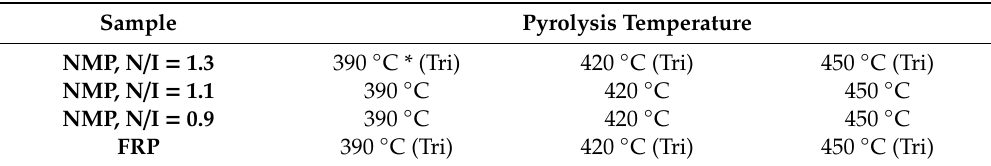
Table 2. Pyrolysis experiments